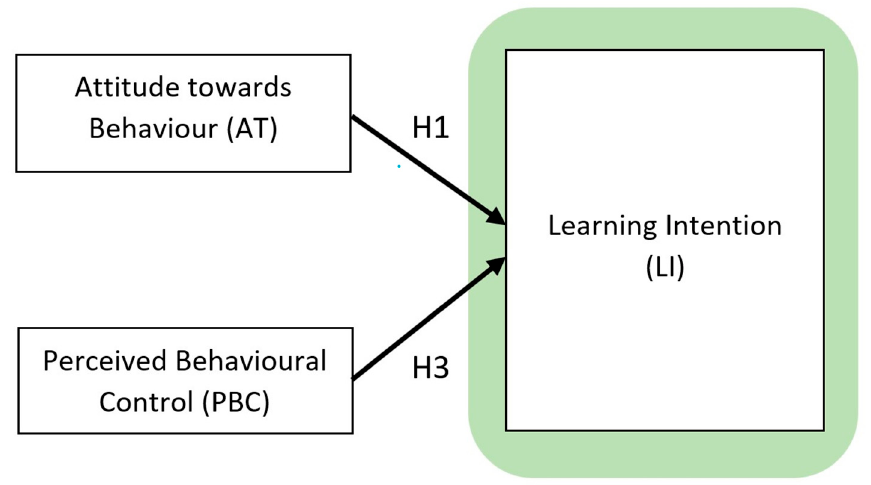
Figure 2. Significant factors in this study.